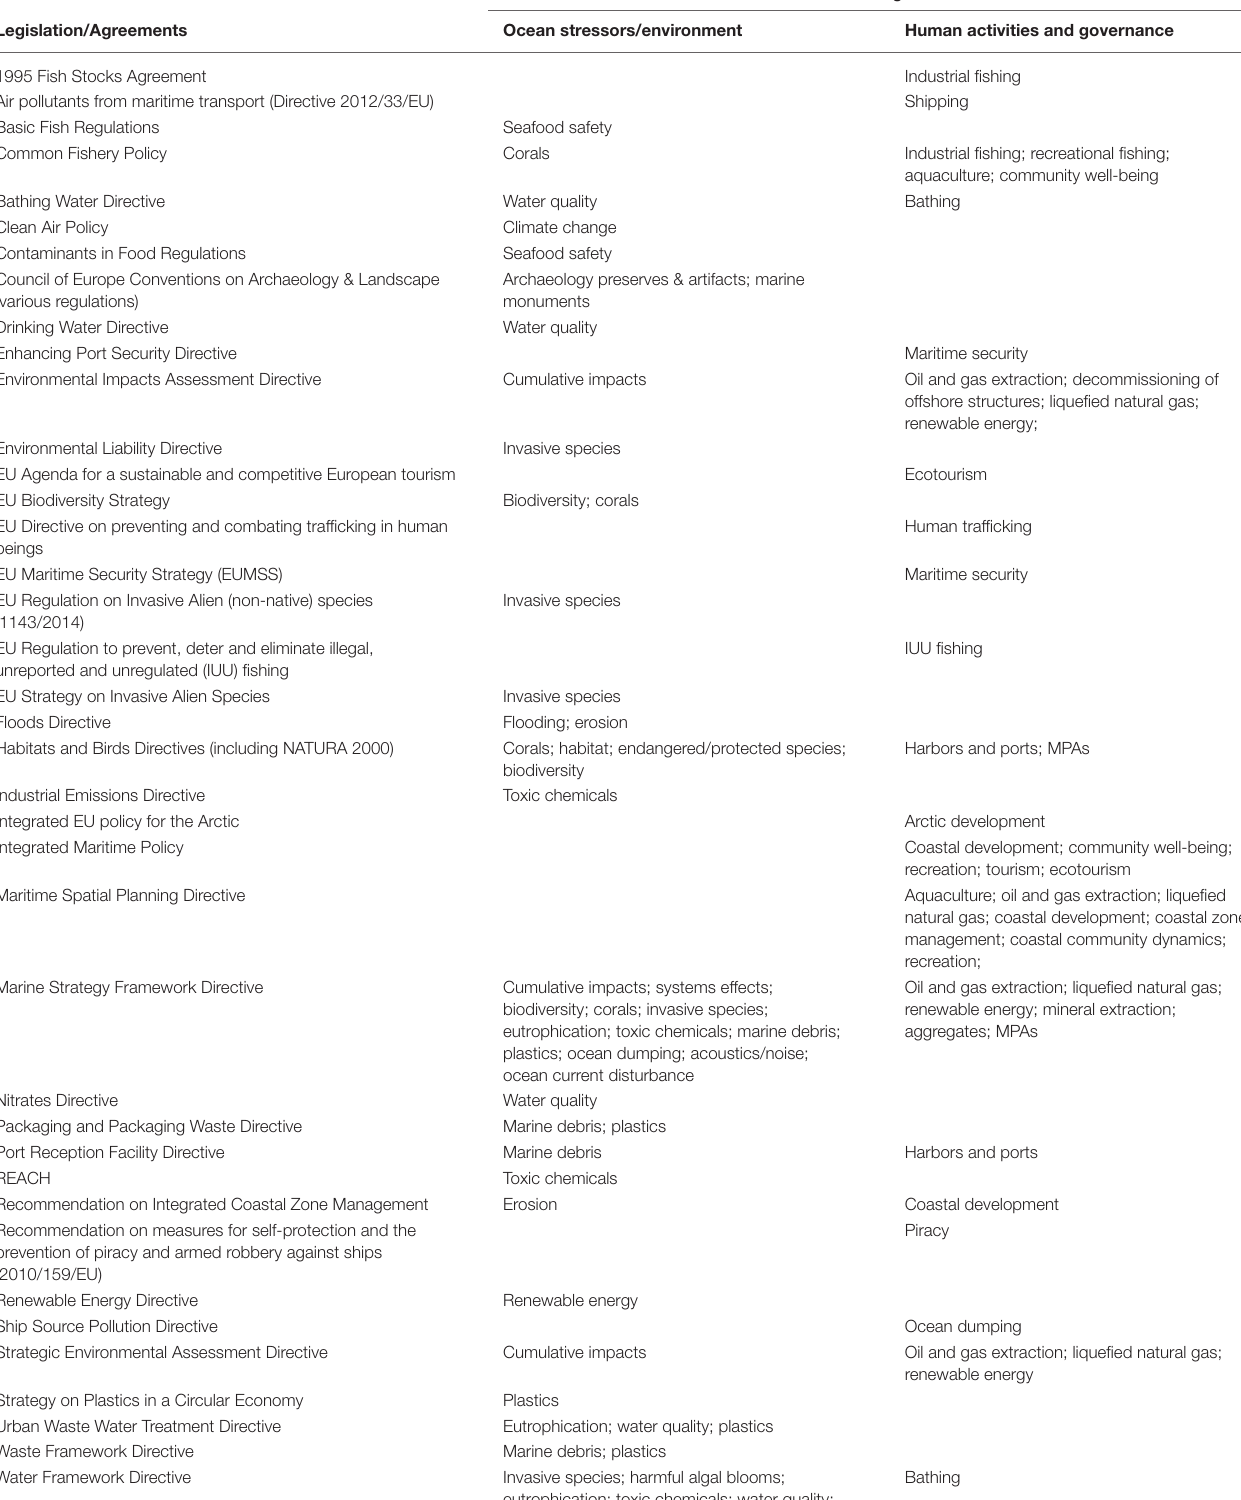
TABLE 3 | EU legislation potentially relevant for